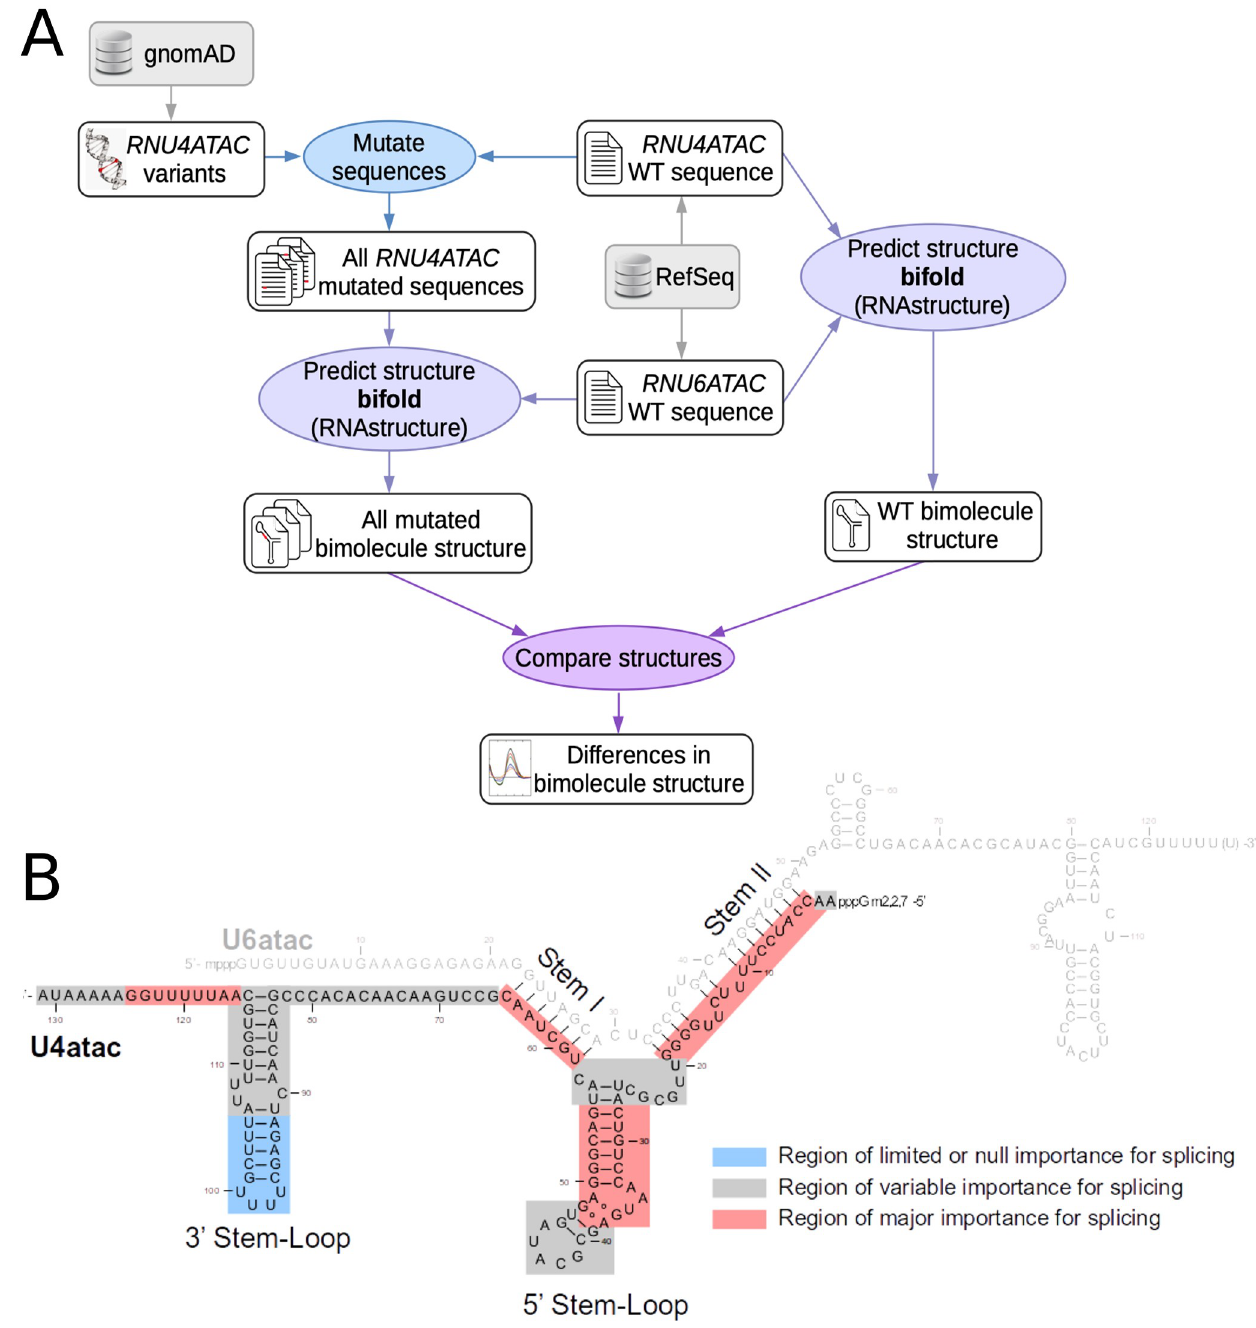
Fig 2. Prediction of the alteration of the U4atac/U6atac bimolecule bi-dimensional structure. A . Schematic diagram picturing the bioinformatic pipeline allowing to compute the scores. After generating the mutated RNU4ATAC sequences for the 285 variants, the secondary structure of all bimolecules formed by wild type U6atac and mutant U4atac was obtained with the bifold function of the RNAstructure package, compared with that of the wild type bimolecule and differences were scored. B . Schematic diagram picturing the importance of U4atac regions for splicing (adapted from [5].) that was used to calculate the score. Score = A x 3 + B x 1 + C x 0.5, where A, B and C are the numbers of modified base pairings in red, grey and blue regions respectively.